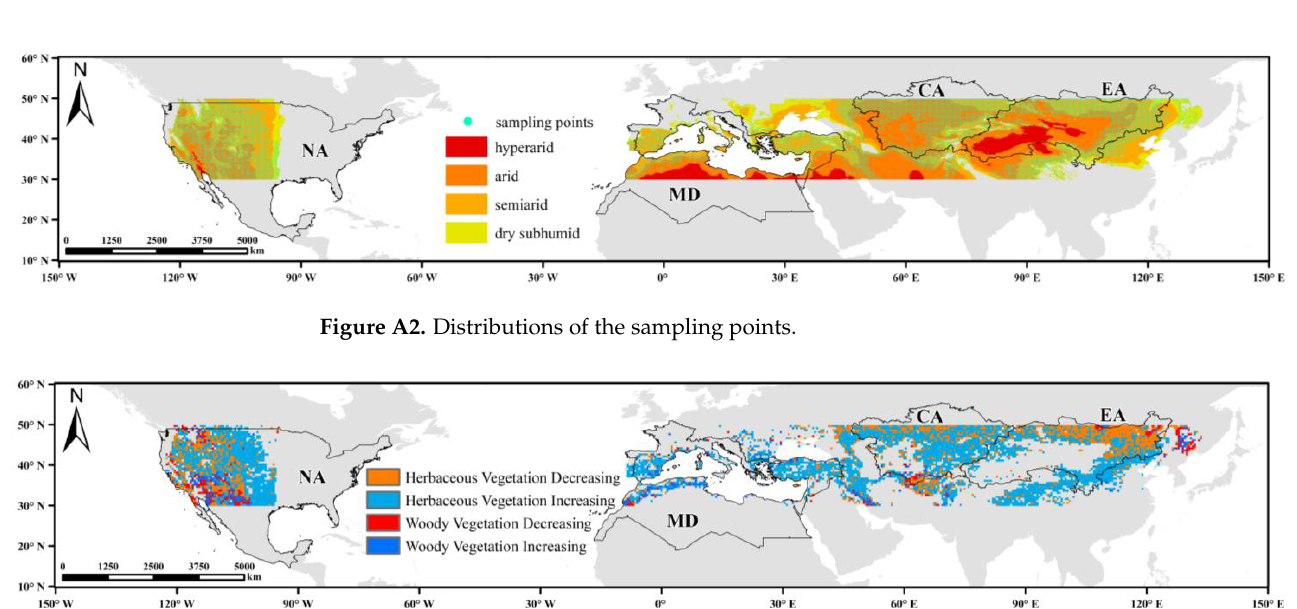
Figure A1. Distributions of herbaceous and woody vegetation.